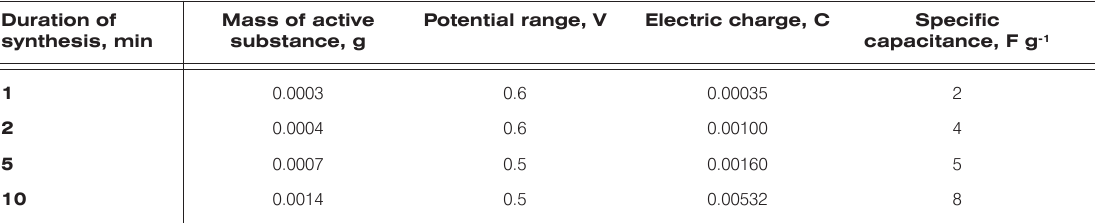
O films on AISI 304 mesh. 3 4